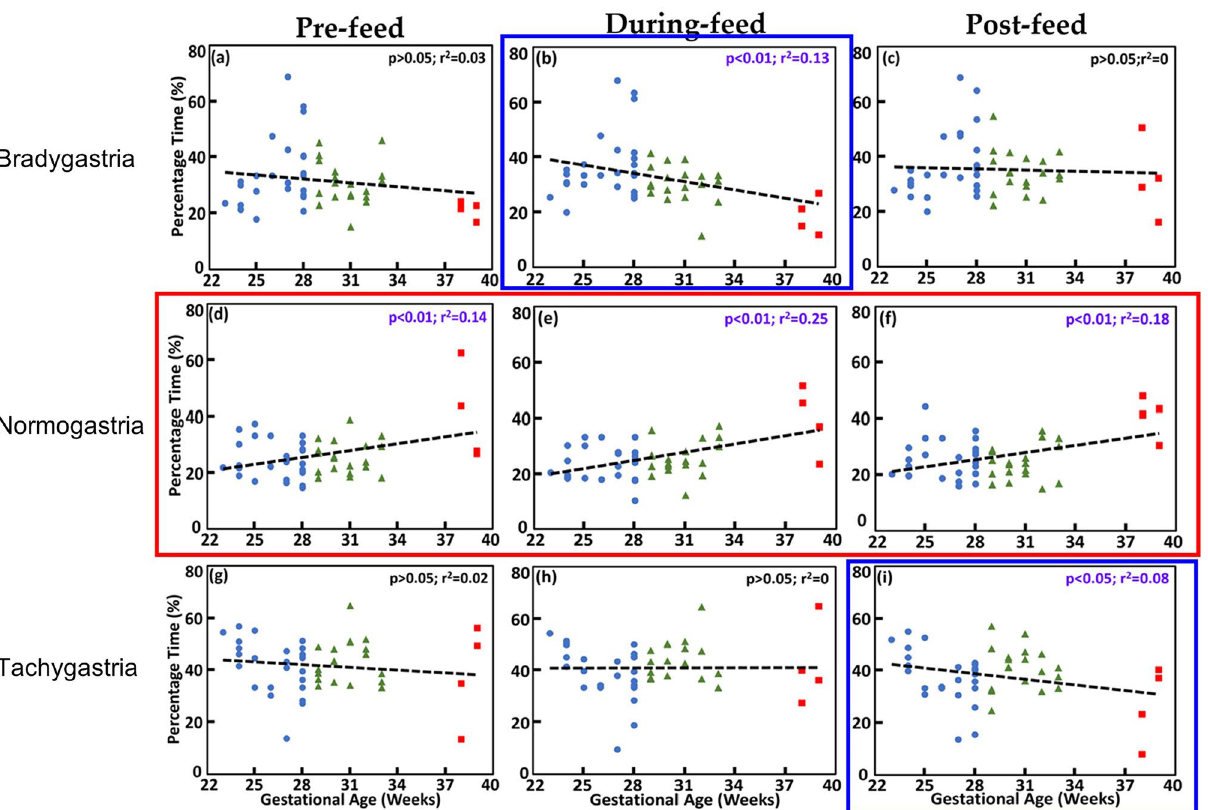
Figure 5. Percentage time spent in each gastric rhythm (GR) band. Percentage time spent in each GR band, namely, % bradygastria (top row), % normogastria (mid row), and % tachygastria (bottom row) for all the three sub-feeding periods. Panels ( a – c ) on the top row depict the % bradygastria in the 3 sub-feeding periods (pre-feed, During-feed, and post-feed, respectively). Panels ( d – f ) on the middle row show the % normogastria in the respective three sub-feeding periods. Panels ( g – i ) on the bottom row illustrate the % tachygastria during the respective three sub-feeding periods. A positive correlation was observed between the % normogastria and GA during each of the three sub-feeding periods, as outlined by the red box. A negative correlation was demonstrated between % bradygastria and GA in the During-feed period and between % tachygastria and GA in the Post-feed period (blue